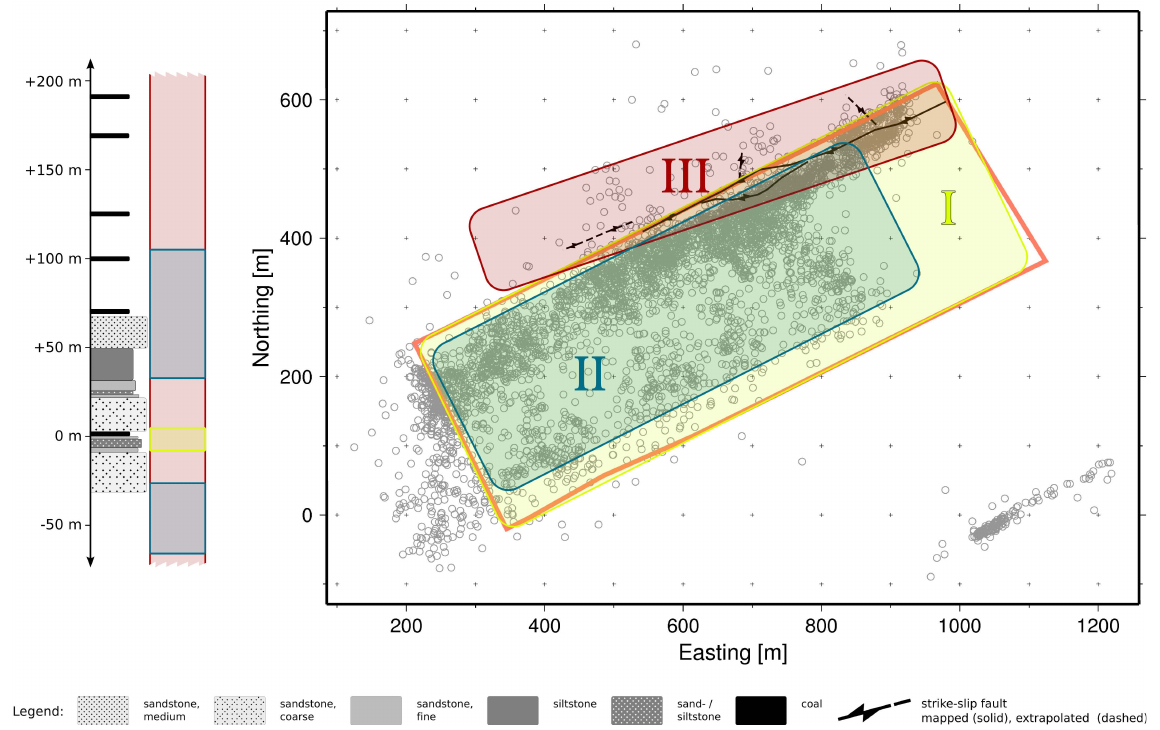
Fig. 13. Mapview of the relocated seismicity of the eight largest clusters (grey circles) and the three main types of brittle failure. On the left hand side there is a lithological column (modified after Alber et al. (2009)) illustrating the abundance of the observed failure types in the context of the geological setting underground. Events of type I (yellow) are directly accompanying the longwall face at mining level reflecting direct stress release by many small magnitude events. Type II (blue) are also events occurring horizontally within panel S109 but at shallower and greater depth reflecting potentially larger magnitude events in prominent rock layers which do not follow GR. Type III (dark red) are events which occur at all depths but concentrated at the northern edge of the longwall panel. This event type shows FMD following GR, thus this failure type has been associated to tectonic faults (information from personal conversation with the mine operator) which are concentrated in this area. Depth values are given relative to the mining level of panel S109. Although only a limited lithological profile is available the alternating sequences of more and less competent layers are also characteristic for the sedimentary bedding between the other indicated coal